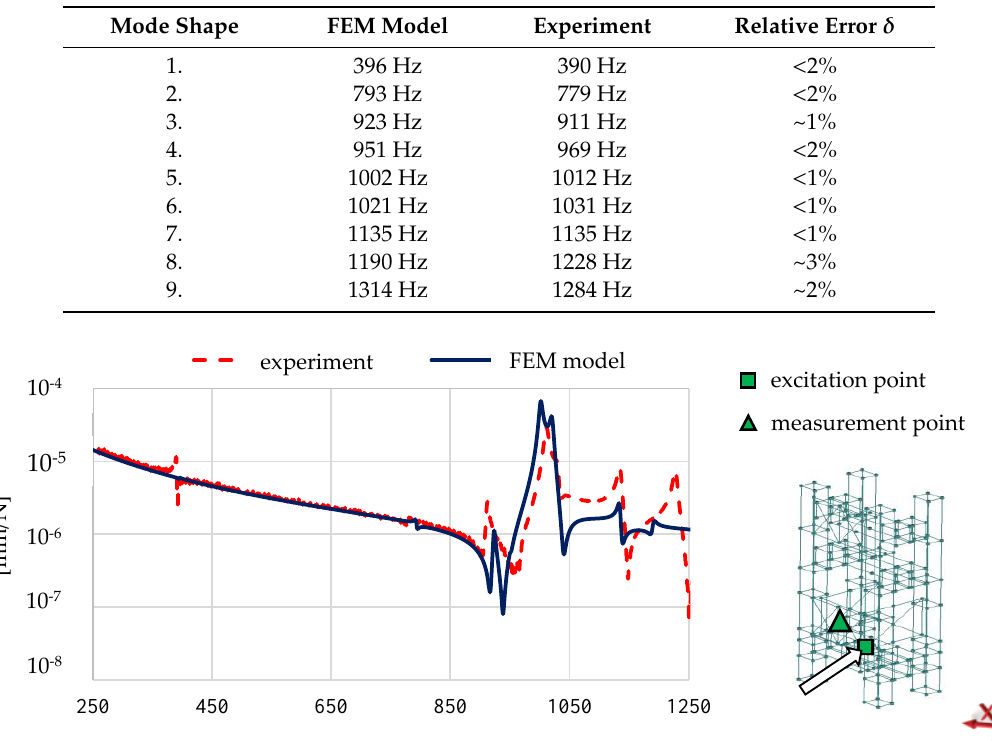
Table 7. Comparison of the values of the calculated and experimental natural frequencies of the steel–polymer concrete frame.